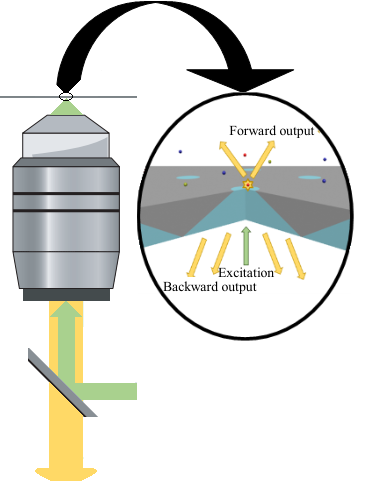
Fig. 3 Scheme for experimental setup for analysis using NFS (this scheme uses backward scattered fluorescent signal for